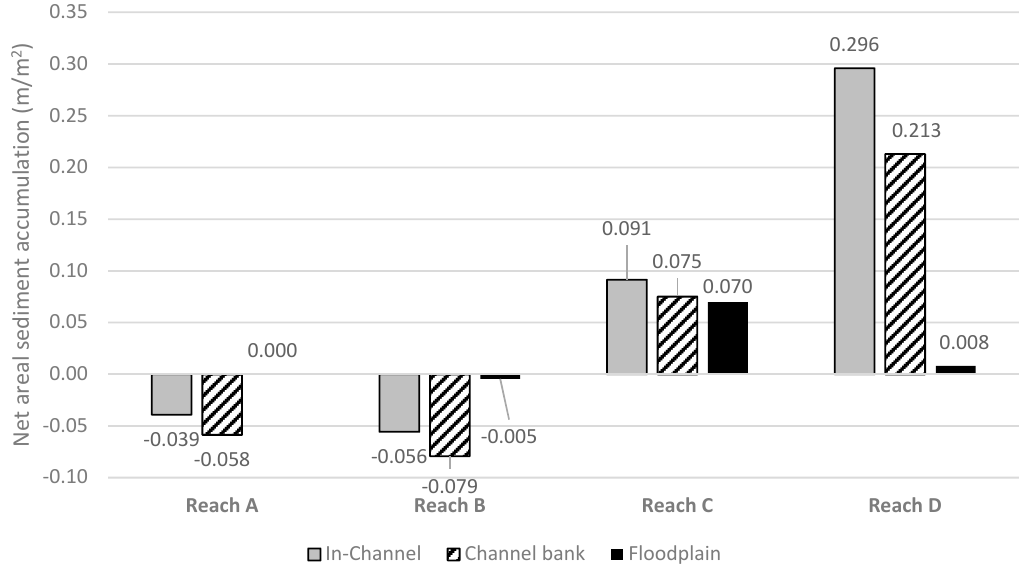
Figure 8. Gross overall in-channel, bank margin and overbank sediment change normalised by area along the River Caldew, split by study reaches .